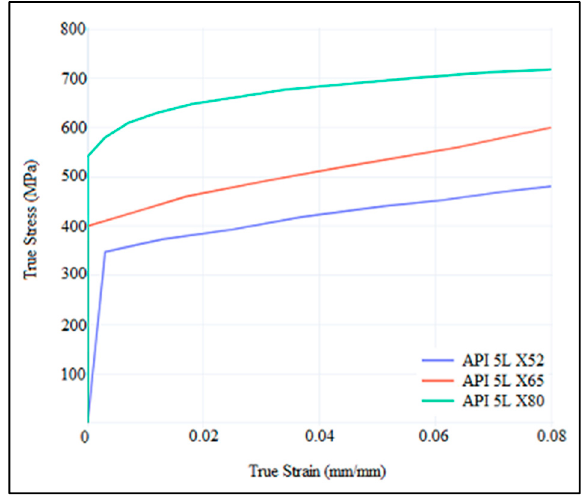
Figure 2. True stress–strain curves for API 5L X52 [2], X65 [3], and X80 steel pipes [18].